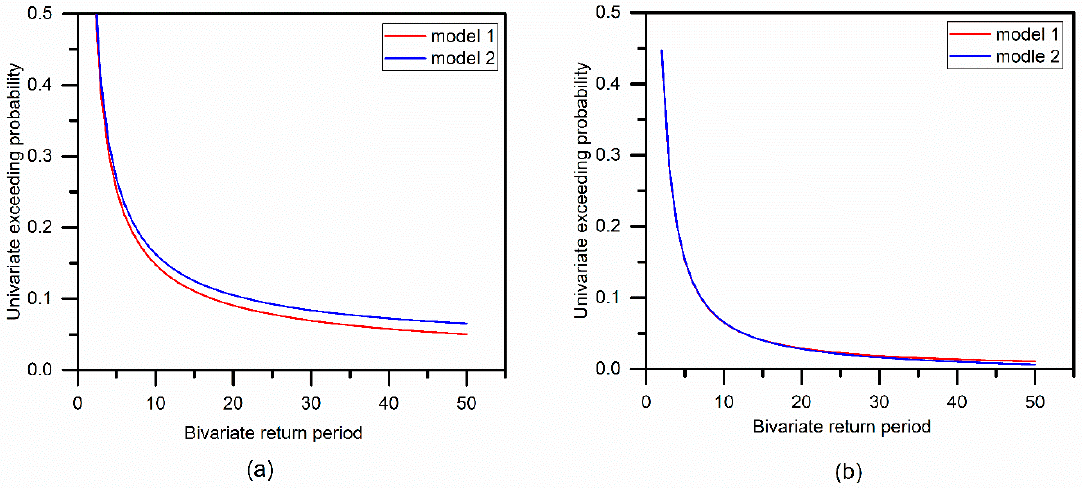
Figure 5. The univariate exceeding probability against the non-stationary return period for ( a ) case AND and ( b ) case OR.